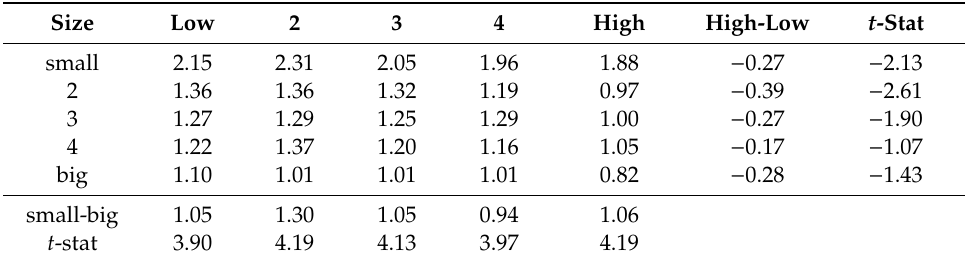
Table 10. Average returns from double-sorted quantile portfolios (sorted by size and Geske’s forward default probability). From the data for July 1963 to December 2013, at the end of each month, stocks are independently sorted into 5 × 5 portfolios based on size and Geske’s forward default probability. The table shows average returns for each of 25 portfolios. Small-big is the return di ff erential between the small and big firm portfolios within each default quantile. High-low is the return di ff erential between the high and low default probability firms within each size quantile. t -statistics are calculated using Newey-West standard errors.